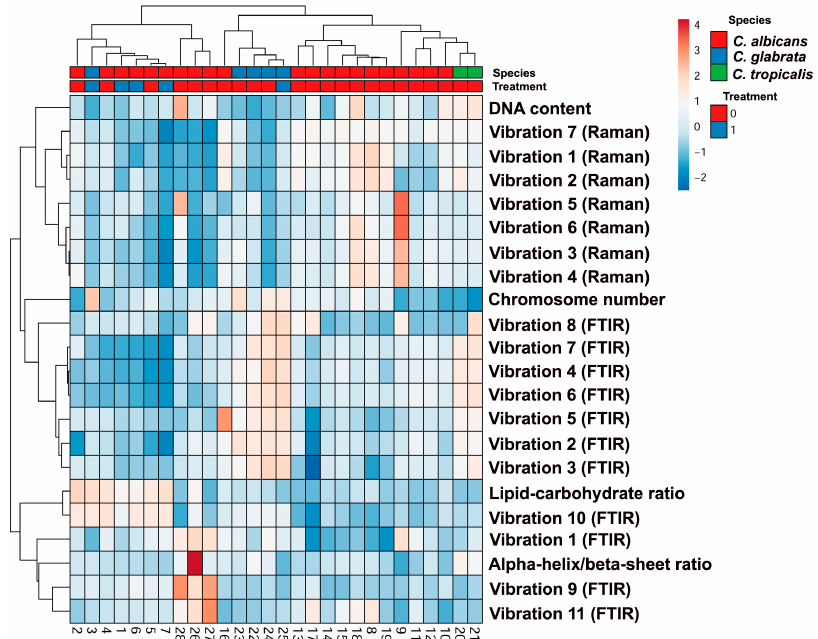
Figure 8. A joined clustering analysis of chromosome number, DNA content, signal intensities of some selected vibrations of FTIR and Raman spectra (11 vibrations of FTIR spectrum, seven vibrations of Raman spectrum), alpha-helix/beta-sheet ratio and lipid-carbohydrate ratio that allows for proper grouping of three Candida species considered. The effect of antifungal treatment is also denoted. A heat map generated from FTIR and Raman spectroscopy data, karyotype profiling, and DNA content data is shown. Hierarchical clustering was created using ClustVis, a web tool for visualizing clustering of multivariate data (BETA) (https://biit.cs.ut.ee/clustvis/). FTIR vibrations: (1) C–O, C–O–H, and C–O–C deformation and C–C stretching vibrations from carbohydrates, (2) β (1–3) glucans, nucleic acids and glycogen, PO 2– symmetric stretching vibrations mainly from RNA, (3) C–O asymmetric stretching vibrations from phospholipids and lipids, (4) amide III: C–N and C–O stretching vibrations, N–H and O=C–N bending vibrations, (5) C=O of COO − symmetric stretching vibrations from proteins, CH 2 wagging vibrations from lipids and β (1–3)glucans, (6) amide II: mainly C–N stretching vibrations and N–H bending vibrations, (7) amide I: mainly C=O stretching vibrations and contributions of N–H bending vibrations, (8) C=O stretching vibrations from lipid esters, (9) CH 2 stretching vibrations from lipids, (10) CH 3 stretching vibrations from lipids, (11) Amide A from proteins; Raman vibrations: (1) symmetric benzene/pyrrole in-phase and out of phase breathing mode of tryptophan and phenylalanine, (2) symmetric benzene/pyrrole in-phase and out of phase breathing mode of tryptophan and phenylalanine, (3) C–H deformation vibrations from proteins, (4) C–H deformation vibrations from lipids, (5) ring stretching vibrations from the deoxyribonucleotide adenosine monophosphate, (6) amide I: mainly C=O stretching vibrations and contributions of N–H bending vibrations, (7) C–H stretching vibration from lipids.